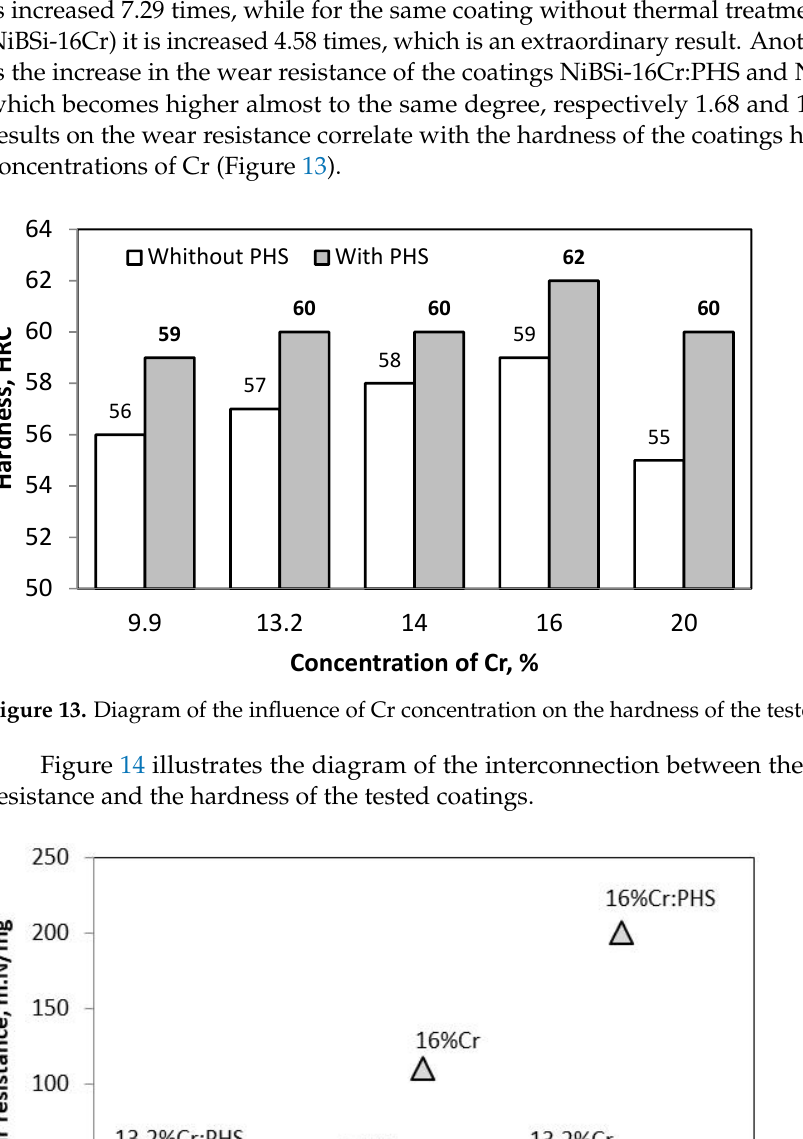
Figure 12. Diagram of the influence of Cr concentration on the wear resistance of the tested coat- ings.